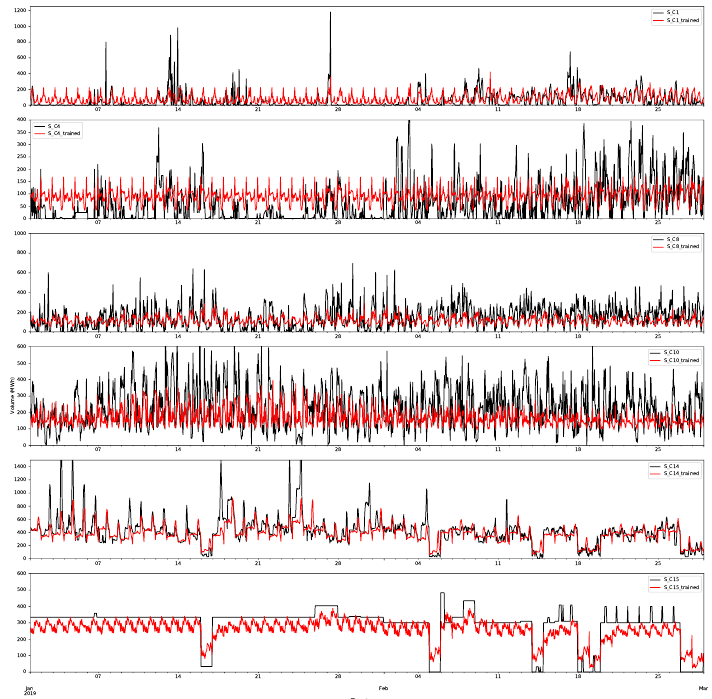
Figure A4. Day-ahead forecasts for selected supply classes in the test set. The forecasts are in red and the actual values are in